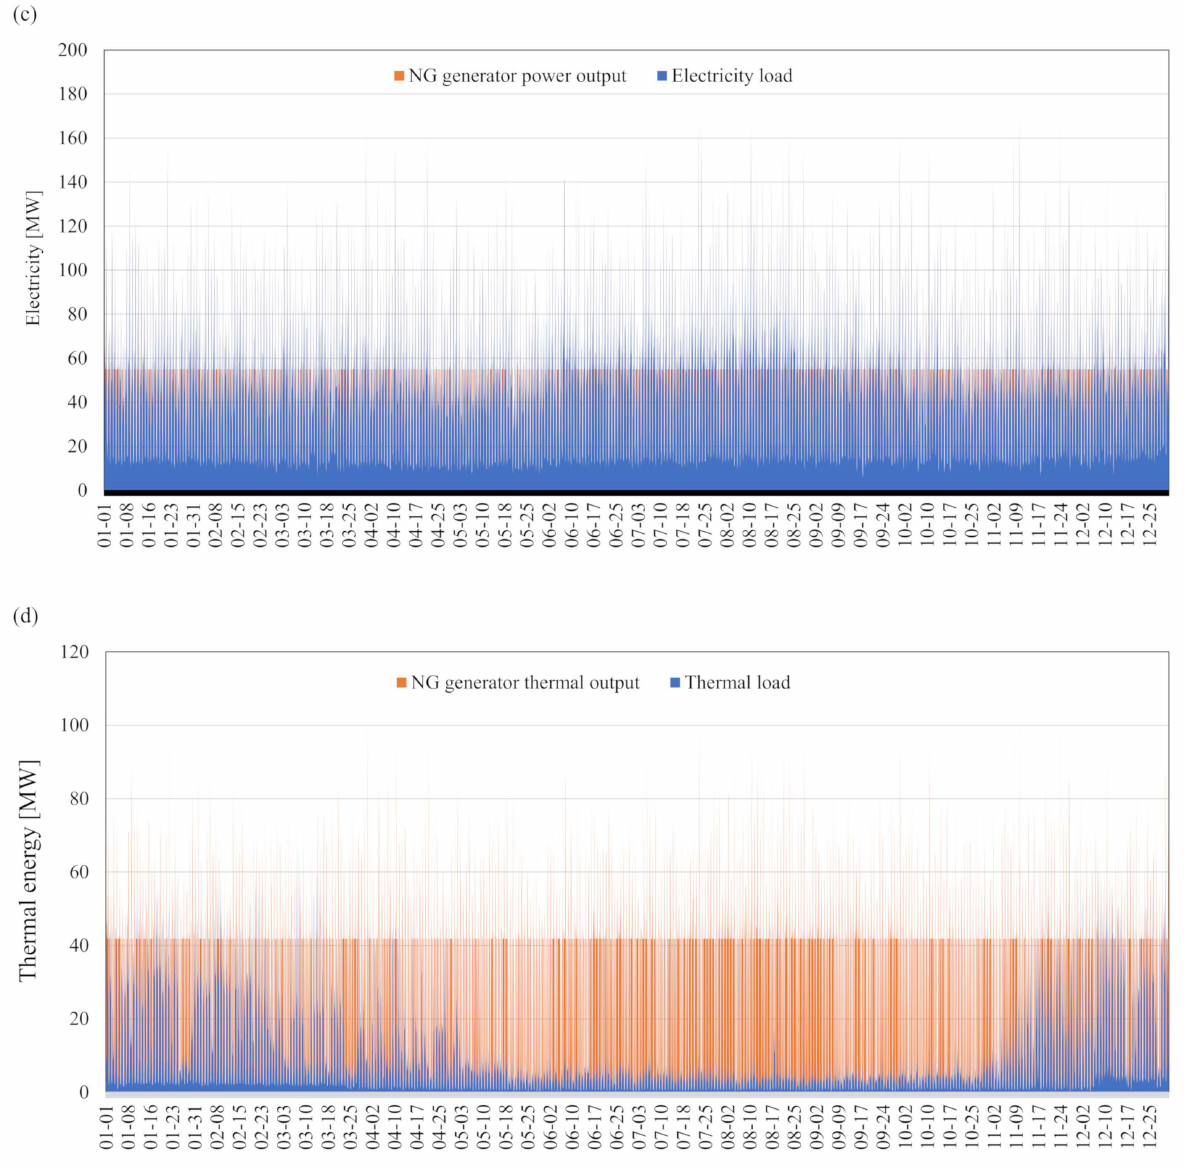
Figure 9. Operating profile of NG generator in base case: ( a ) monthly electricity balance, ( b ) monthly thermal balance, ( c ) hourly electricity balance, ( d ) hourly thermal